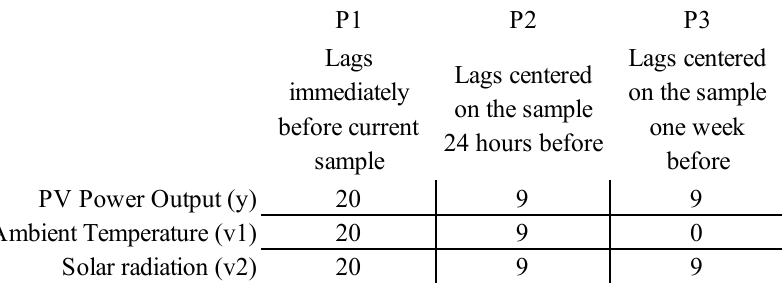
Figure 4. Honda Smart Home ( HSH) model lags.